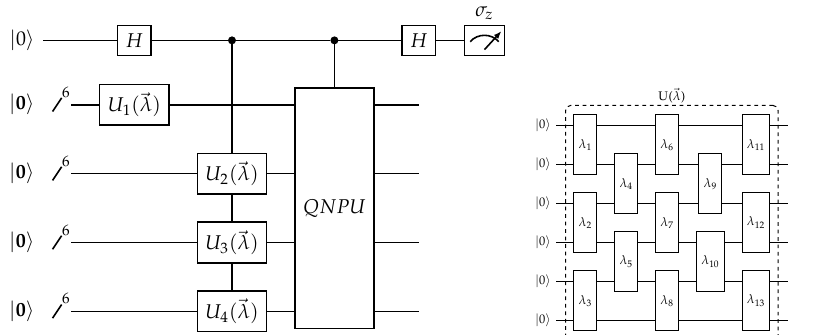
Figure 1. Illustration of the Variational Quantum Computing (VQC) approach, shown here for four layers, each with 6 input qubits and depth 5 for the operators U ( (cid:126) λ ) with 13 variational parameters defining two-qubit gates. The Quantum Non-linear Processing Unit ( QNPU ) is designed to efficiently create non-linear products using problem-specific quantum circuits. The figure is adapted from Lubasch et al.